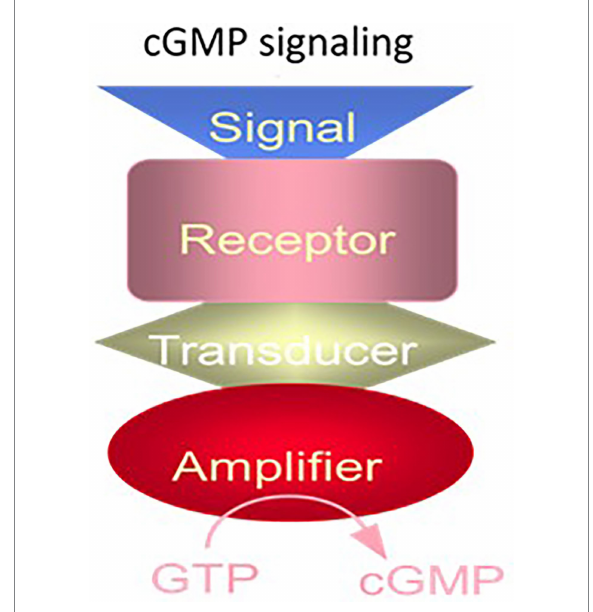
FIGURE 2 The cyclic GMP signaling system. The cyclic GMP signaling system consists of a single protein. The hormonal signal is recognized by the extracellular receptor domain; the signal is potentiated at the ATP-modulated ARM domain located next to the transmembrane domain in the intracellular portion of the protein (transducer) and the signal is amplified by the cyclase catalytic domain located at the C-terminus of the protein. (Modified from Sharma and Duda,